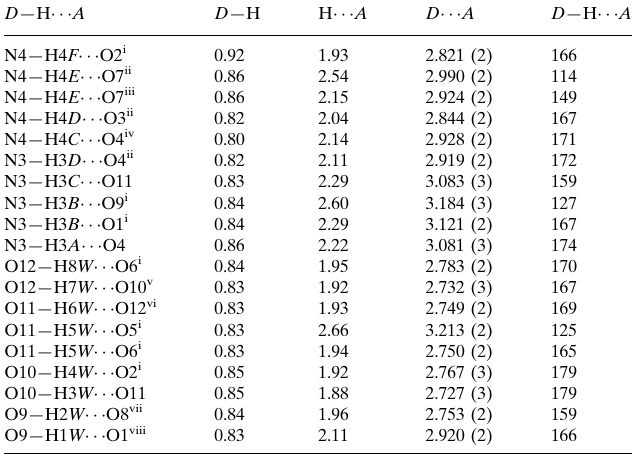
Hydrogen-bond geometry (A˚ , (cid:3)